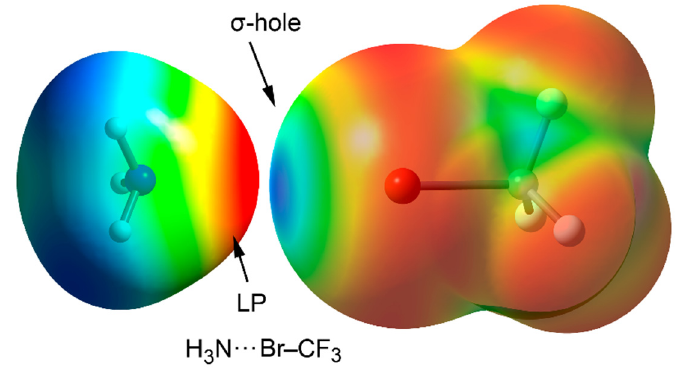
Figure 1. MEP surface of an σ -hole complex between NH 3 and BrCF 3 molecules acting as electron donor and acceptor moieties, respectively. Electropositive regions are represented in blue and electronegative in red.